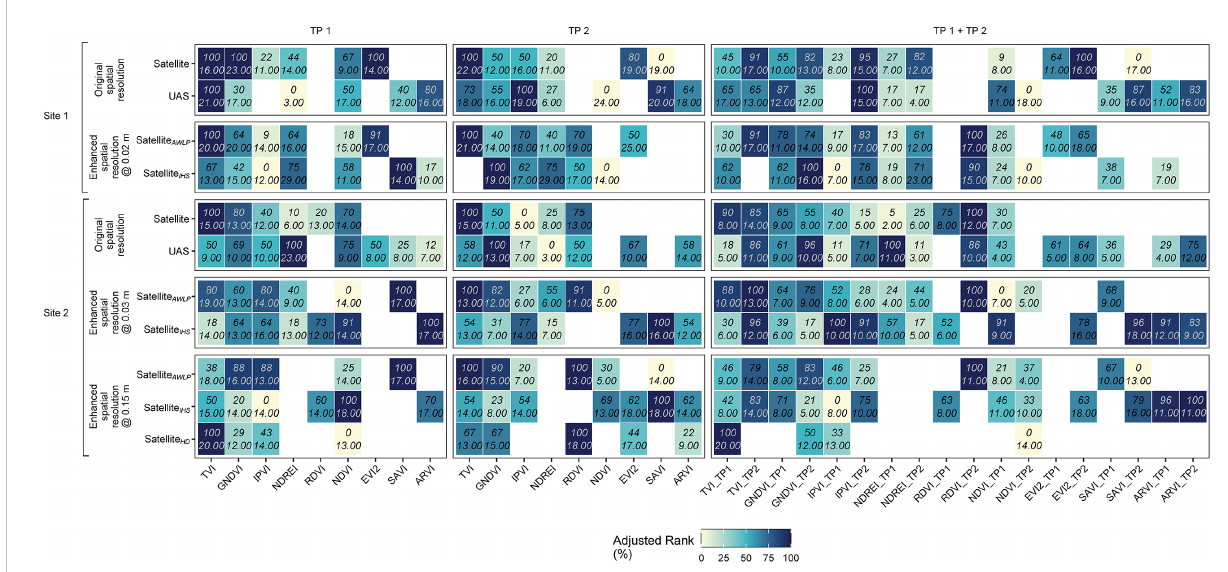
FIGURE 11 Adjusted rank (%) extracted to evaluate the feature importance from random forest models developed using different datasets. The comparison was made with respect to original (satellite and UAS) and pan-sharpened imagery across multiple time points and trials. In each square, there are two numbers, the top one indicates adjusted rank (%) and bottom one in, italics , is indicative of mean importance